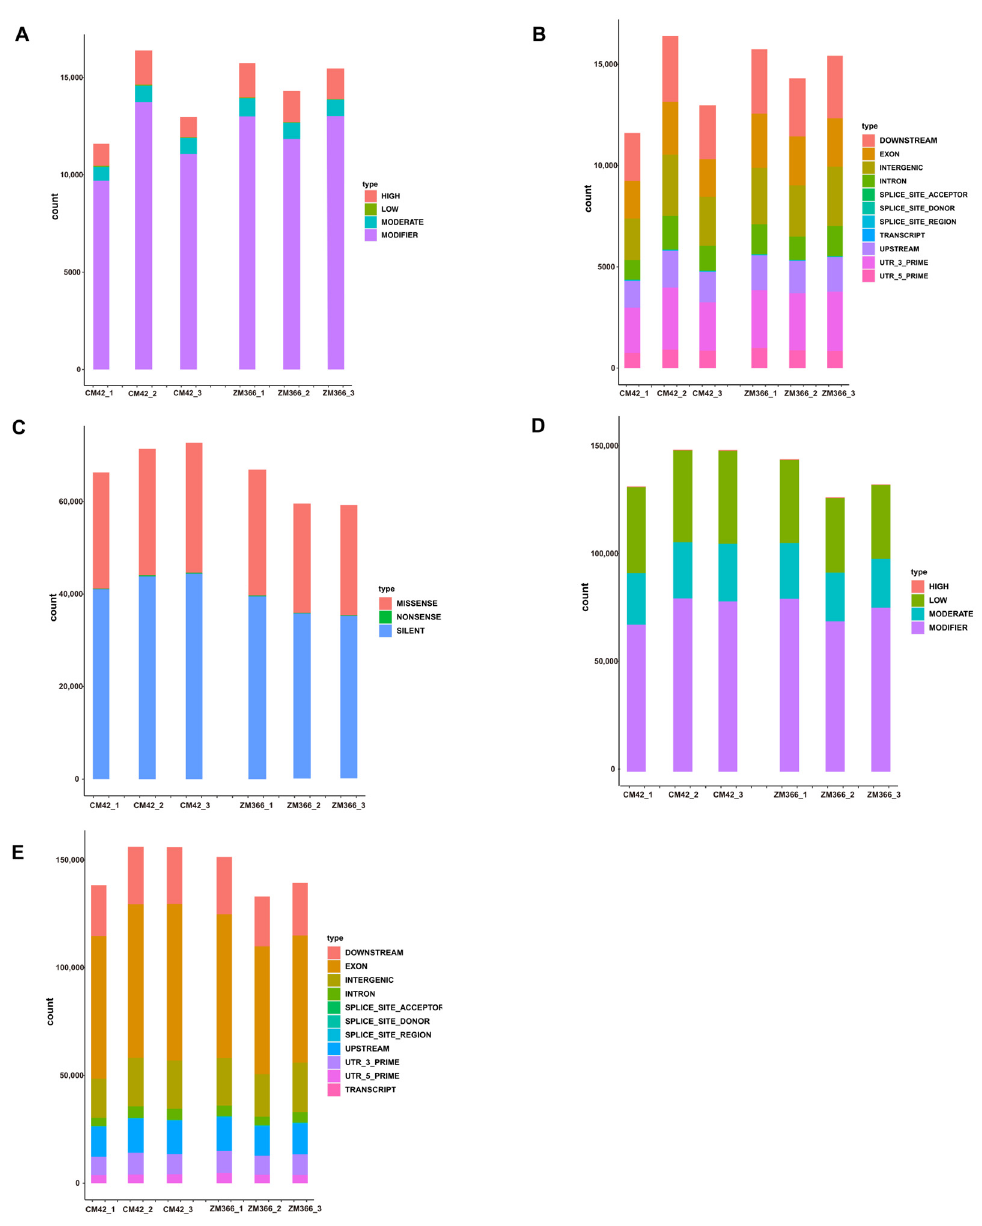
Figure 3. Statistics for variant sites, including InDels and SNPs. ( A ) InDel-impact was plotted for four levels: high, moderate, low, and modifier. ( B ) InDel-region was counted for the following gene structure regions: downstream, exon, intron, intergenic, splice_site_acceptor, splice_site_donor, and splice_site_region, transcript, upstream, utr_3_prime and utr_5_prime. ( C ) SNP-function was statistically plotted for three conditions: synonymous mutation, missense mutation, and nonsense mutation. ( D ) SNP-impact was statistically plotted for four levels: high, moderate, low, and modifier. ( E ) SNP-region was counted and mapped for the following gene structure regions: downstream, exon, intron, intergenic, splice_site_acceptor, splice_site_donor, and splice_site_region, transcript, upstream, utr_3_prime and utr_5_prime.